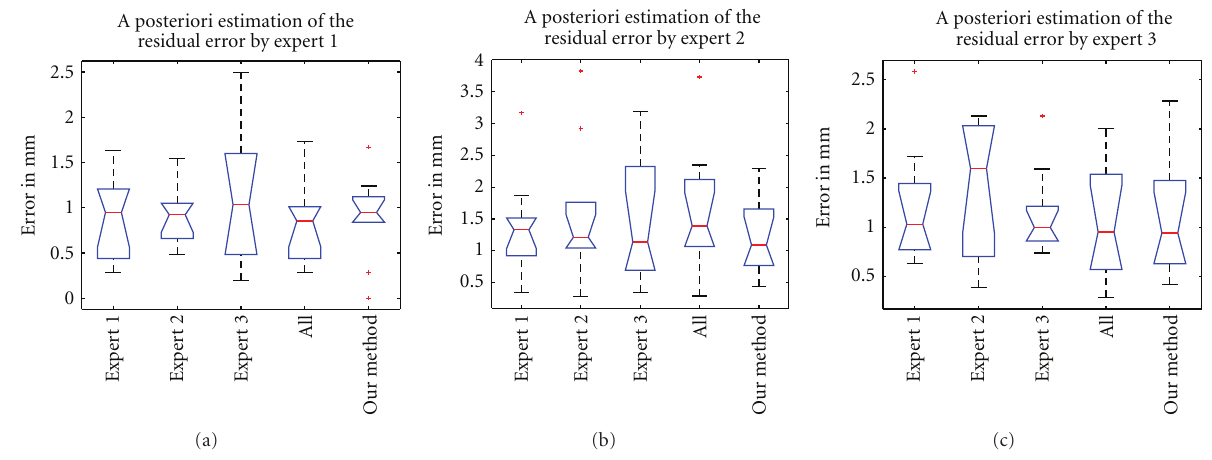
Figure 10: A posteriori residual error (in mm) estimated for all transformations by each expert.